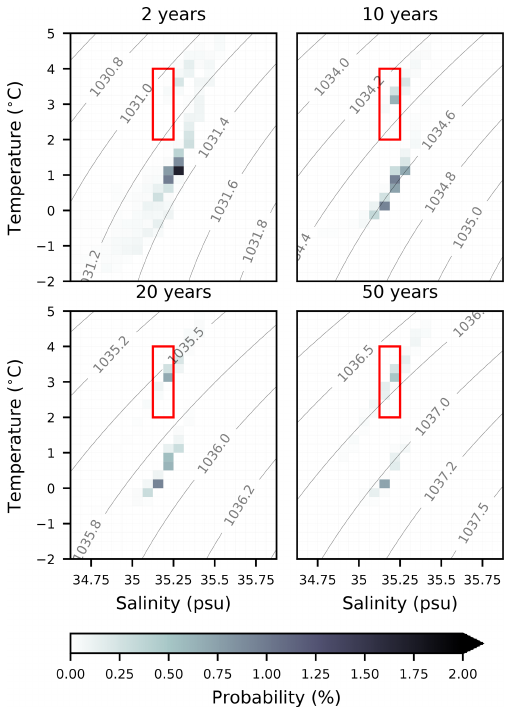
Figure 16. As in Fig. 12 but for Arctic-outcropping NADW. Note that the region enclosed by the red box is the same in both subpolar- (Figs. 12 and 14) and Arctic-outcropping